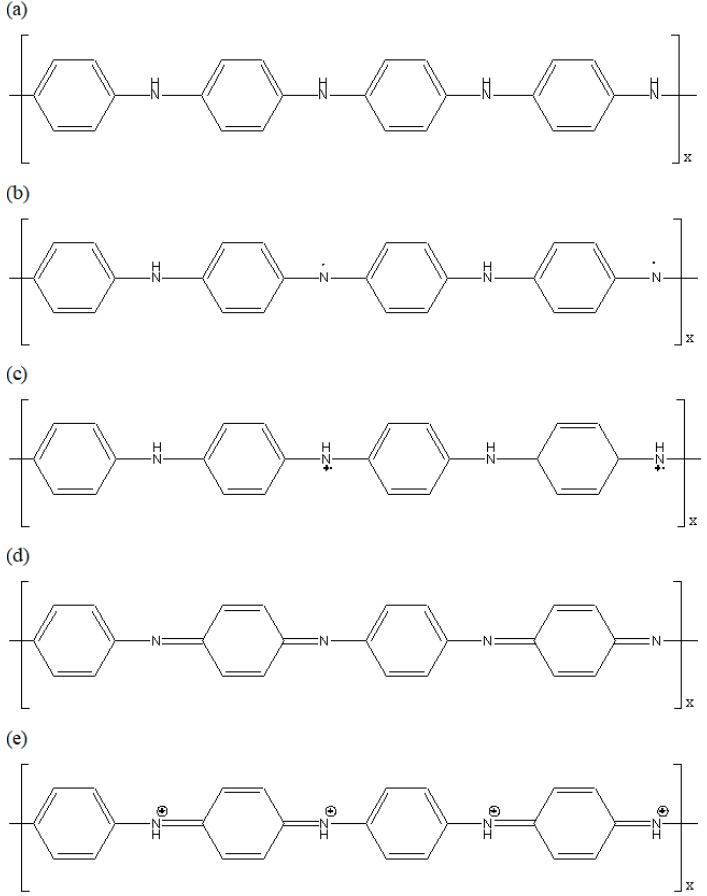
Figure 1. Different oxidation states of PANI. ( a ) leucoemeraldine (white/colourless); ( b ) emeraldine base (blue); ( c ) emeraldine salt (green); ( d ) pernigraniline base (violet); ( e ) pernigraniline salt (blue).